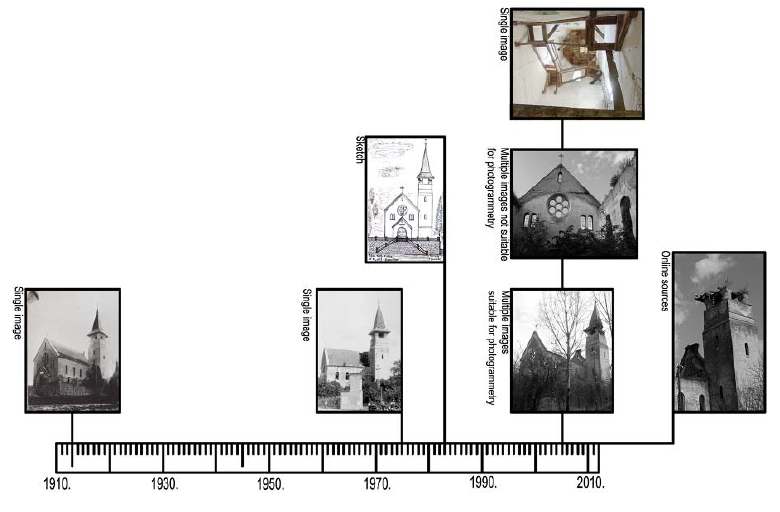
Figure 2. The available